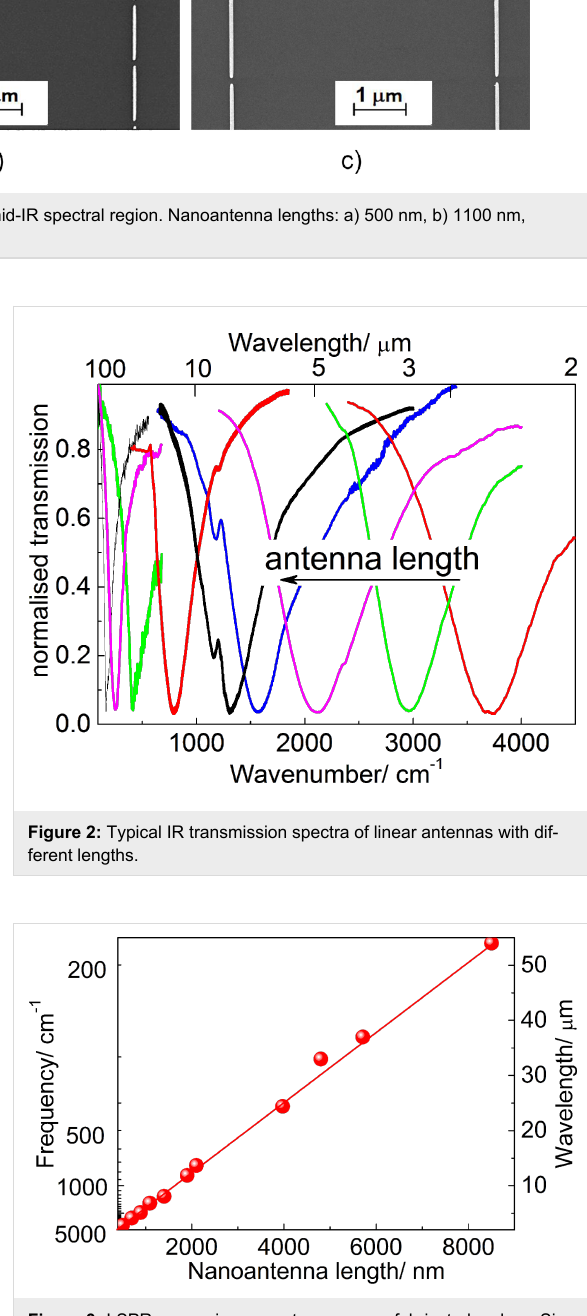
blue-shifted by about 1000 cm − 1 with respect to the structures on bare Si due to the significant difference between the dielec- tric functions of Si and SiO 2 . With decreasing SiO 2 layer thick- ness, starting from about 30 nm, a rapid transition from